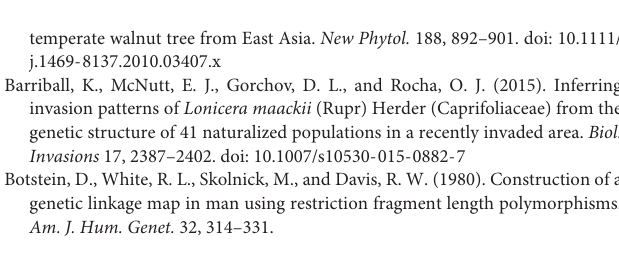
Supplementary Table S1 | Population information. Supplementary Table S2 | Sequencing information. Supplementary Figure S1 | The optimal K value. Supplementary Figure S2 | Phylogenetic tree of 134 individuals based on SNP data matrix. Supplementary Figure S3 | Structure analysis of K =